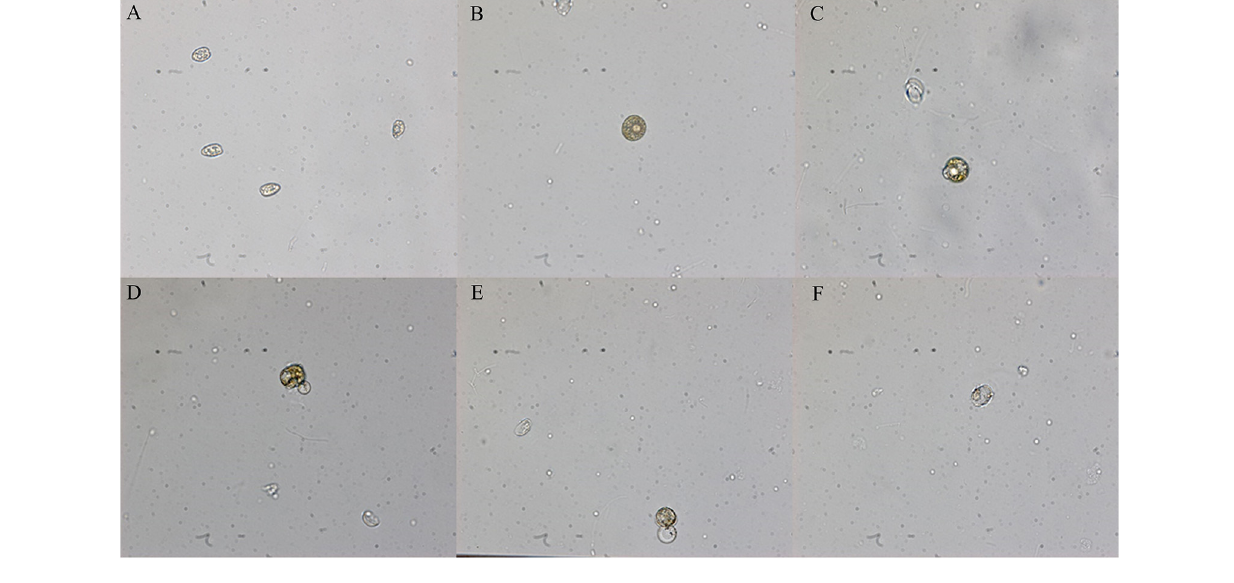
FIGURE 5 | Morphological changes of Prorocentrum donghaiensis caused by hijiki extract (40 × objective lens). (A) Normal cells; (B) round cells; (C) small exospores; (D) medium exospores; (E) large exospores; (F) dead